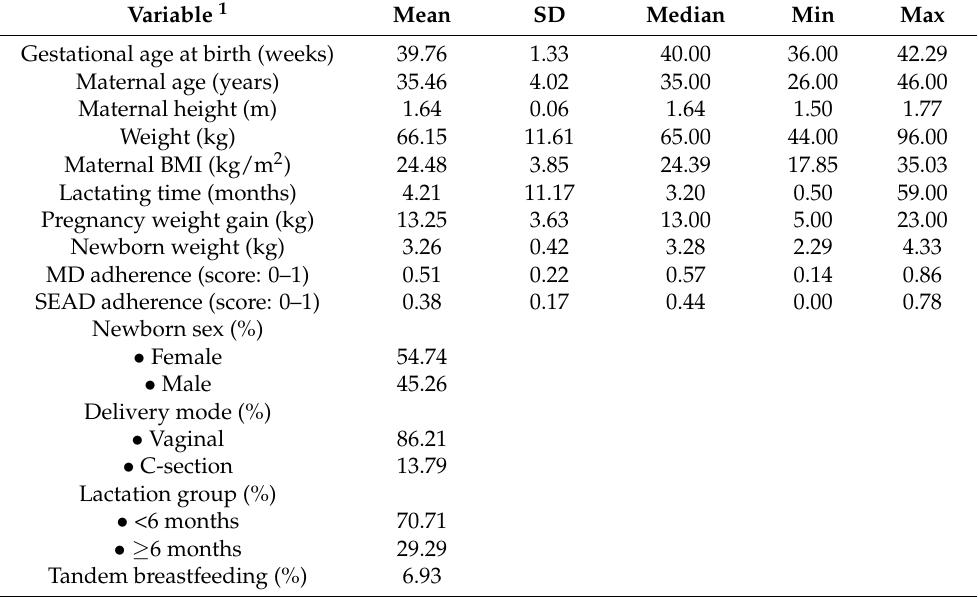
Table 3. Descriptive summary of the lactating women ( n = 99) participating in this study, showing anthropometric and sociodemographic characteristics, index of adherence to healthy dietary patterns (Mediterranean Diet, MD; Southern European Atlantic Diet, SEAD), pregnancy, and delivery data. Variable 1 Mean SD Median Min Max Gestational age at birth (weeks) 39.76 1.33 40.00 36.00 42.29 Maternal age (years) 35.46 35.00 1.64